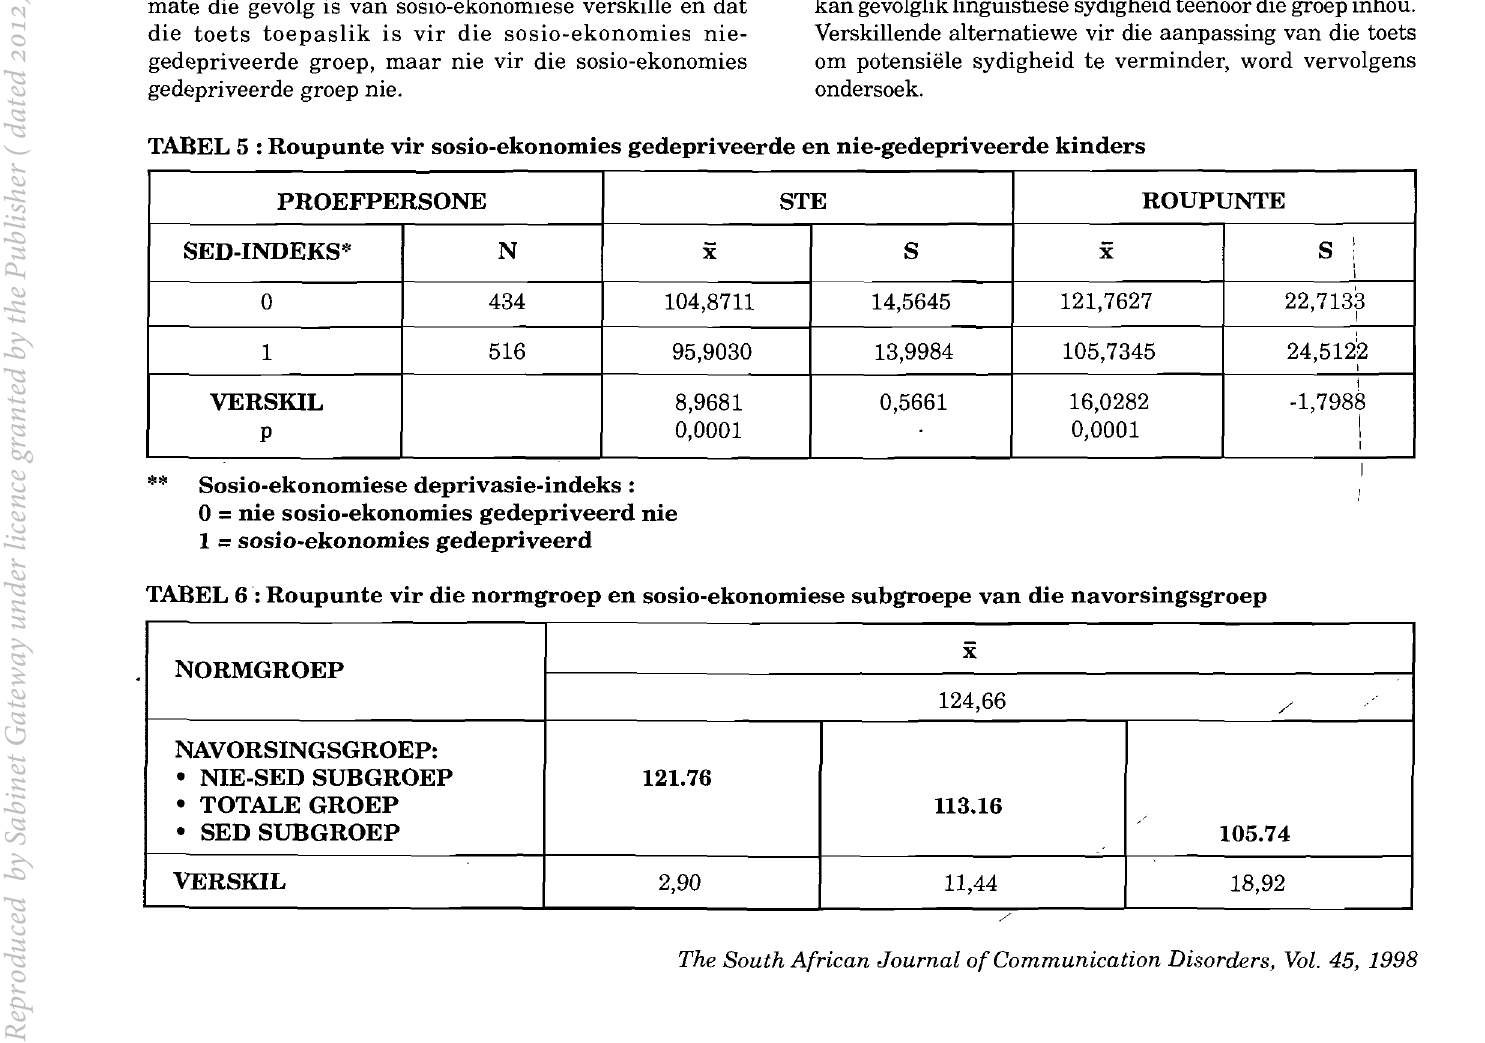
TABEL 5 : Roupunte vir sosio-ekonomies gedepriveerde en nie-gedepriveerde kinders